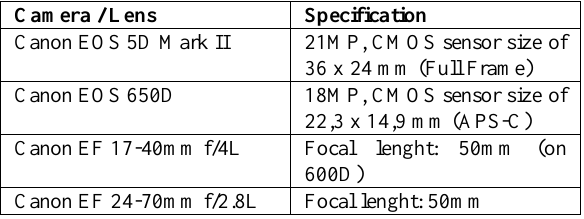
Table 1 Specifications of cameras and